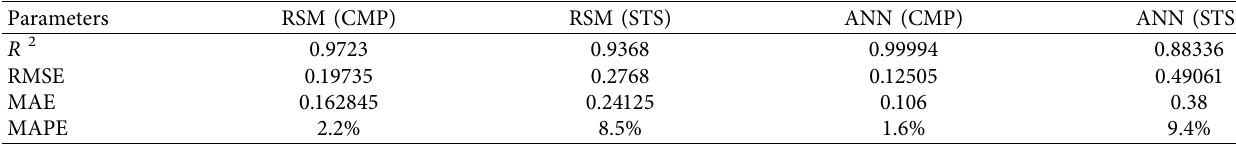
Table 6: Validation and comparison of RSM and ANN